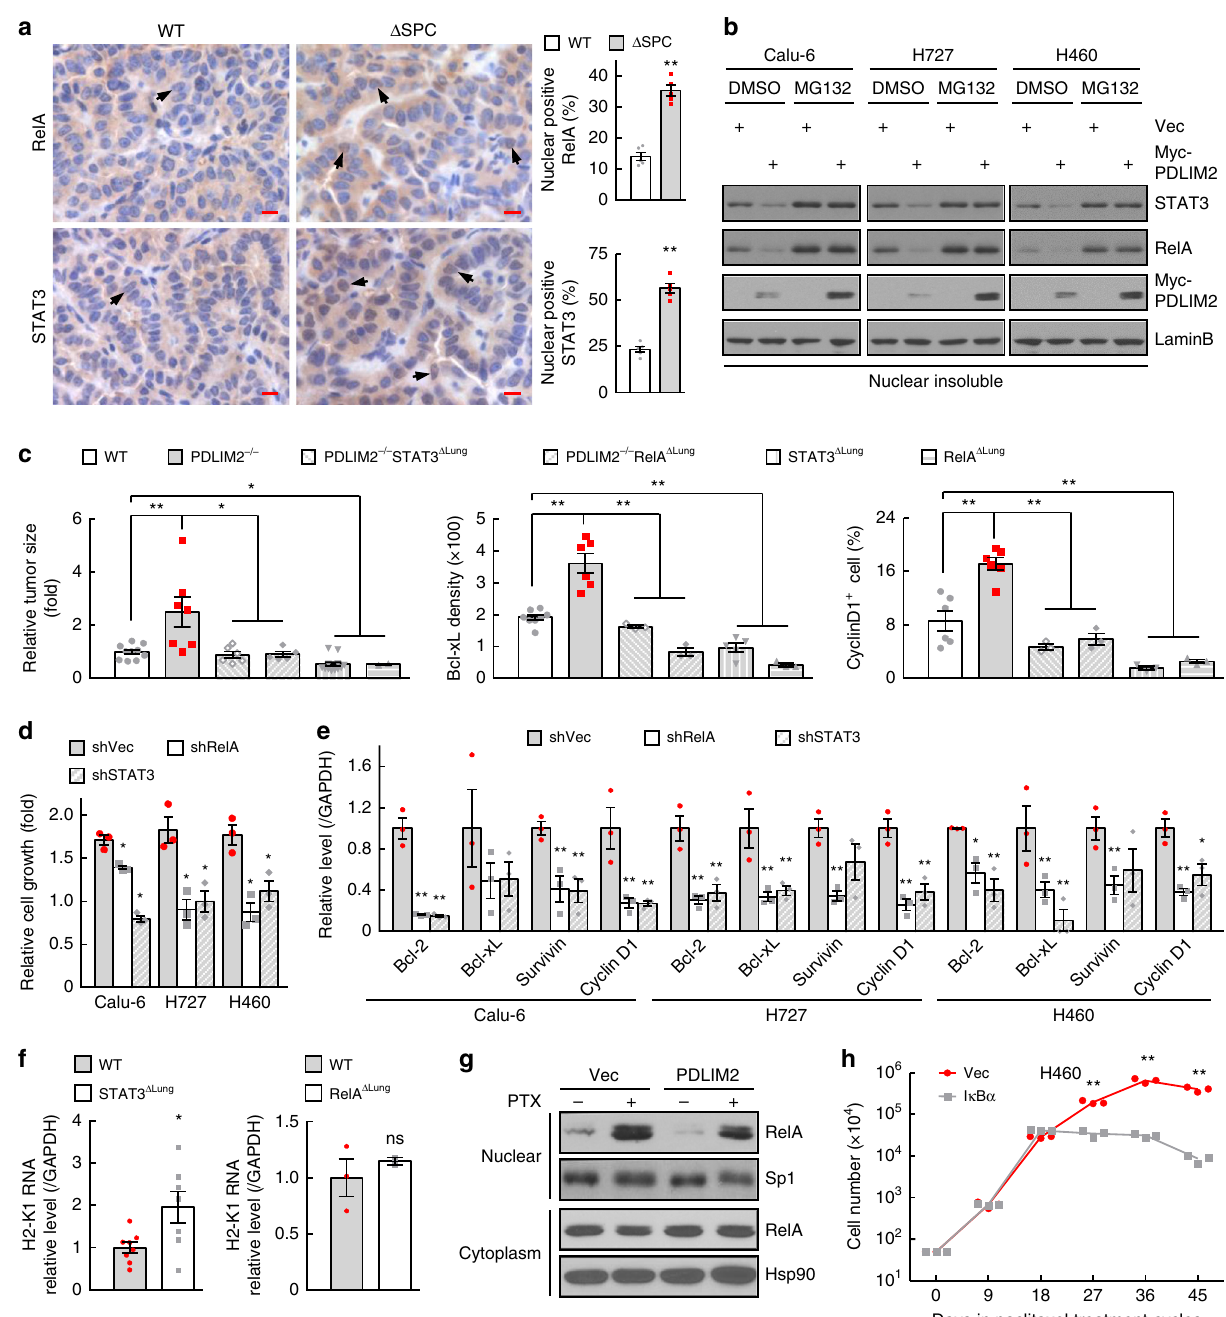
Fig. 6 PDLIM2 represses STAT3 and RelA to increase MHC-I and repress cancer-related genes for suppressing lung cancer development and therapeutic resistance. a IHC staining showing increased nuclear RelA and STAT3 in lung cancers by PDLIM2 deletion in urethane model ( n = 5). Scale bar, 10 μ m. b Nuclear fraction-IB assays showing increased proteasomal degradation and decreased expression of nuclear RelA and STAT3 in the indicated human lung cancer cells reconstituted with PDLIM2 in the presence or absence of the proteasome inhibitor MG132. c K-Ras G12D model showing suppression of increased lung tumors in PDLIM2 − / − mice by tumor-selective RelA or STAT3 deletion. Mouse numbers: WT, 10; PDLIM2 − / − , 7; PDLIM2 − / − STAT3 Δ Lung , 6; PDLIM2 − / − RelA Δ Lung , 5; STAT3 Δ Lung , 12; RelA Δ Lung , 2. d Cell growth assays showing decreased growth of the indicated human lung cancer cells by RelA or STAT3 shRNA knockdown (KD) ( n = 3). e qPCR analysis showing decreased expression of the indicated growth-related genes in the indicated human lung cancer cells by RelA or STAT3 KD ( n = 3). f qPCR analysis showing increased H2-K1 expression in lung tumors by STAT3 deletion ( n ≥ 7) but not RelA deletion ( n ≥ 2) (urethane model). g Subcellular fraction-IB assays showing much lower paclitaxel induction of nuclear RelA in H460 human lung cancer cells reconstituted with PDLIM2. h Cell growth assays showing increased paclitaxel sensitivity of H460 cells by stable I κ B α expression ( n = 3). Student ’ s t test (two tailed, unpaired) was performed in ( a , c – f , h ). Data represent means ± SEM in ( a , c – f ). * P < 0.05; ** P < 0.01; ns, not statistically signi fi